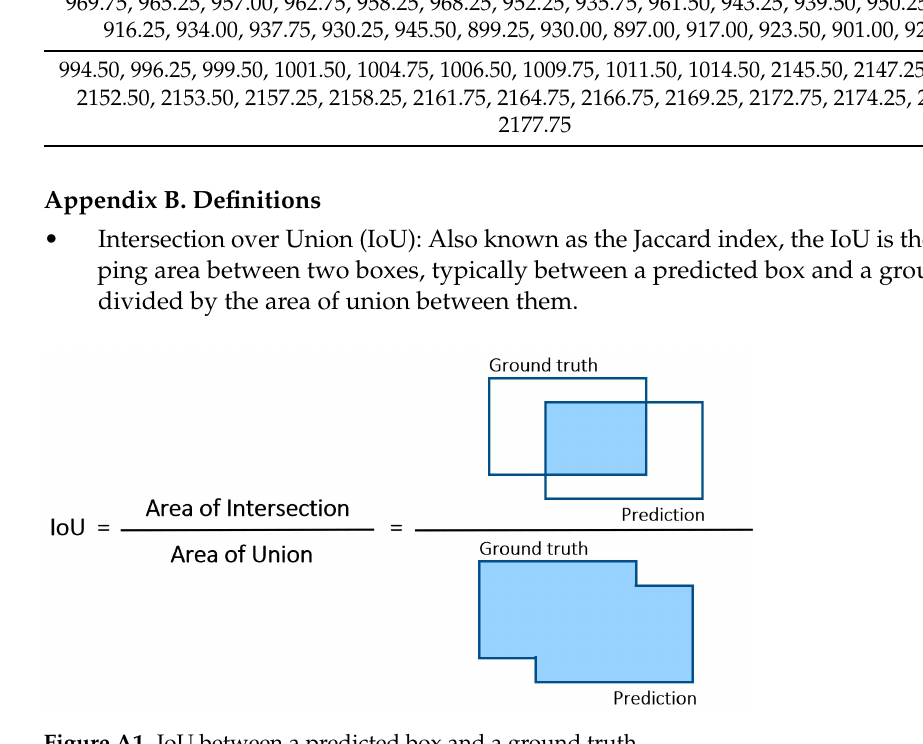
Figure A1. IoU between a predicted box and a ground